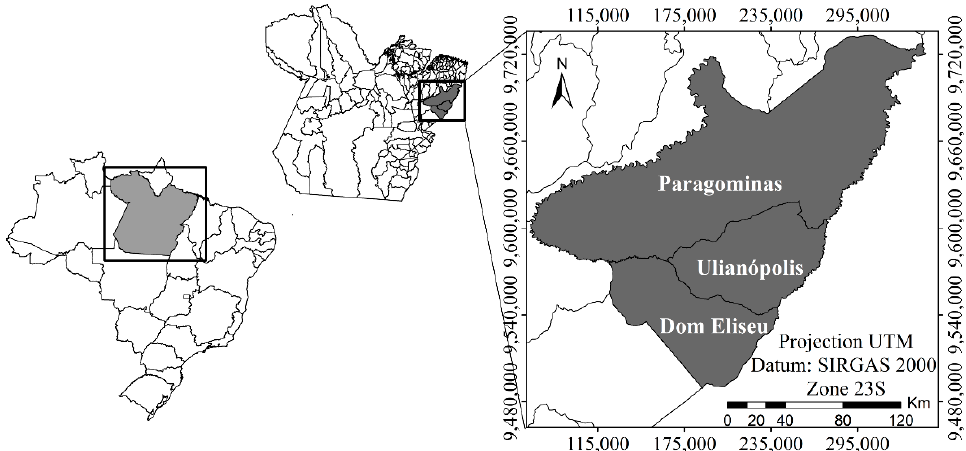
Figure 1. Location of the municipalities of Dom Eliseu, Paragominas, and Ulianópolis, southeast mesoregion of the Pará state, Brazil, generated with ArcGIS 10.4.1 software.